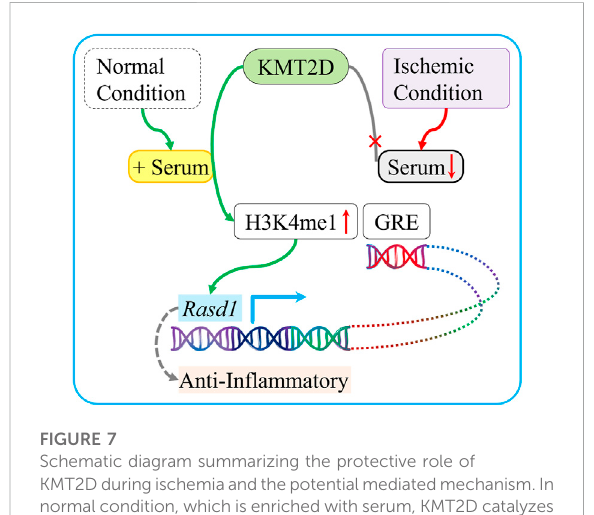
FIGURE 7 Schematic diagram summarizing the protective role of KMT2Dduringischemiaandthepotentialmediatedmechanism.In normal condition, which is enriched with serum, KMT2D catalyzes H3K4 mono-methylation on the Rasd1 enhancer region and promotes Rasd1 transcription in cardiomyocyte. In ischemic condition, serum de fi ciency leads to interruption of H3K4me1 that modi fi ed by KMT2D on GRE of Rasd1 and then reduces Rasd1